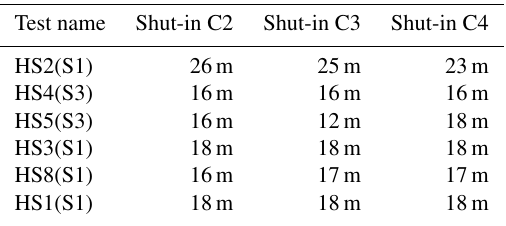
Table 5. Distance of strain transition zone (change from a vari- able to compressional strain field) to the injection point measured at shut-in of injection cycles 2, 3 and